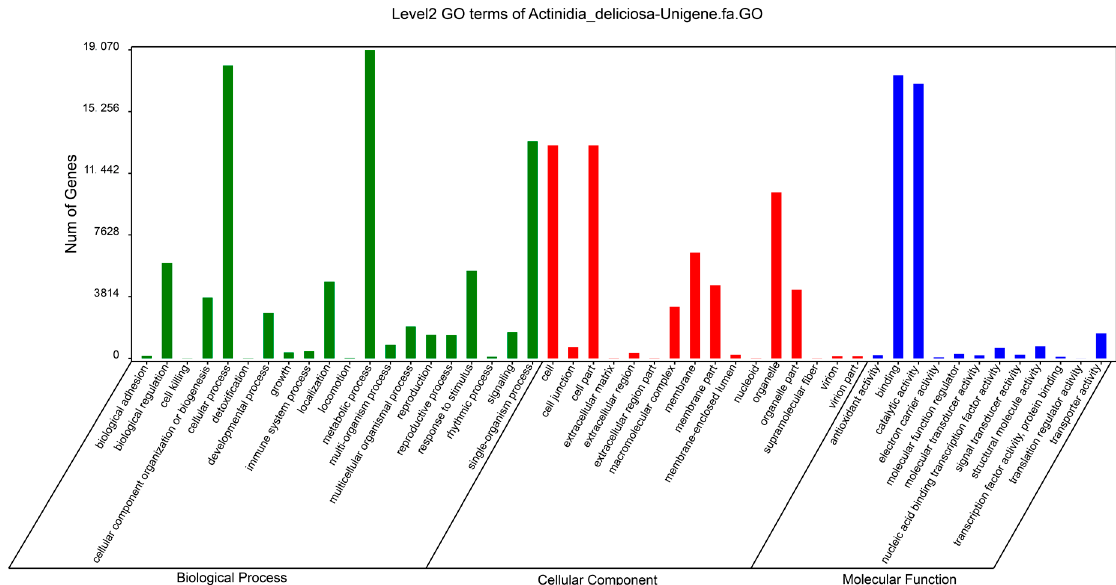
Figure 1. Gene Ontology classification of unigenes.